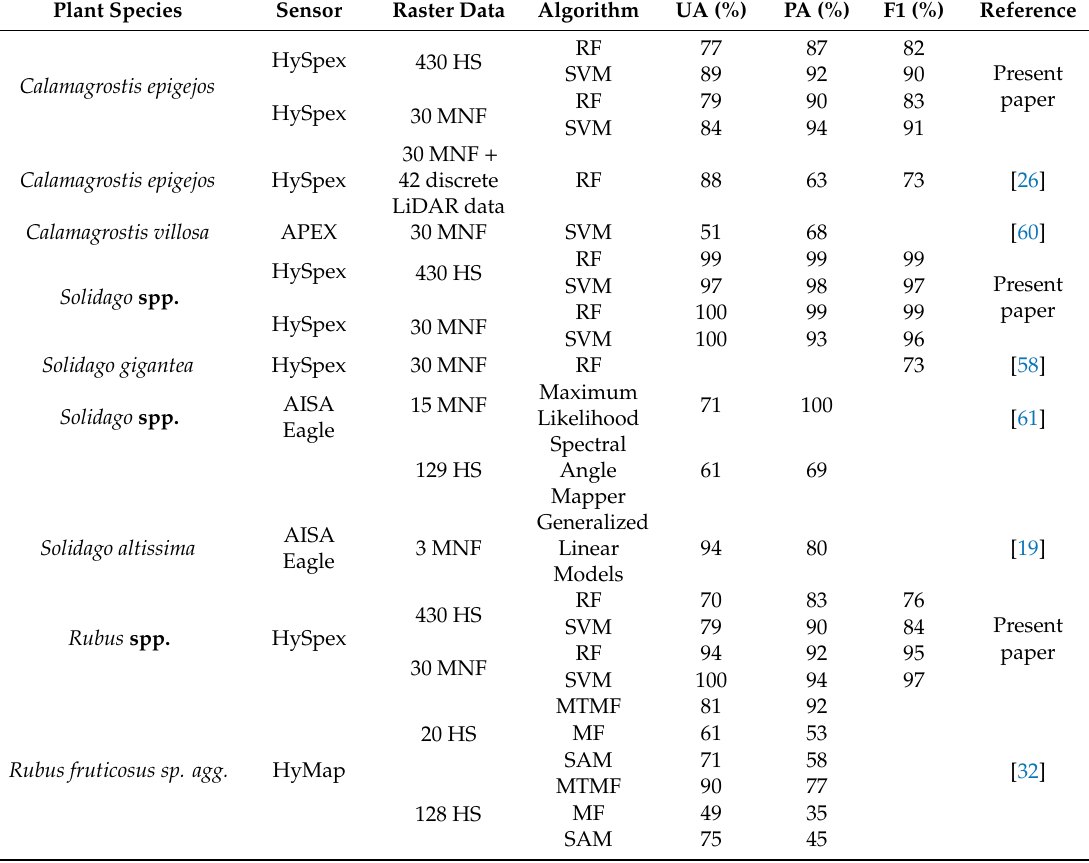
Table 5. Comparison of acquired results with